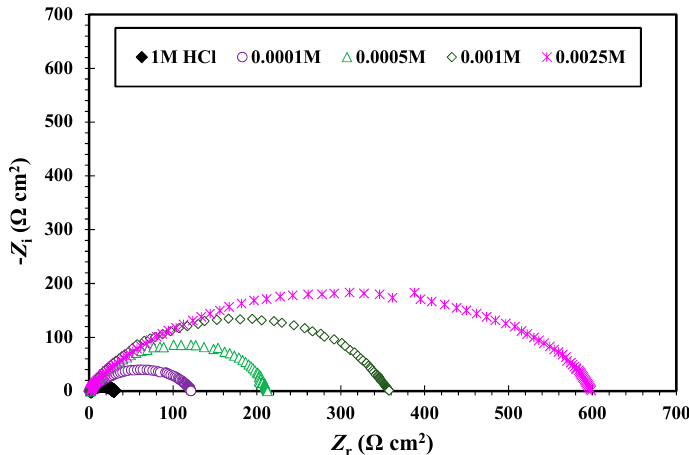
Figure 7. Nyquist plots for MS in 1 M HCl in the absence and presence of different concentrations of CGSES12 at 20 °C.